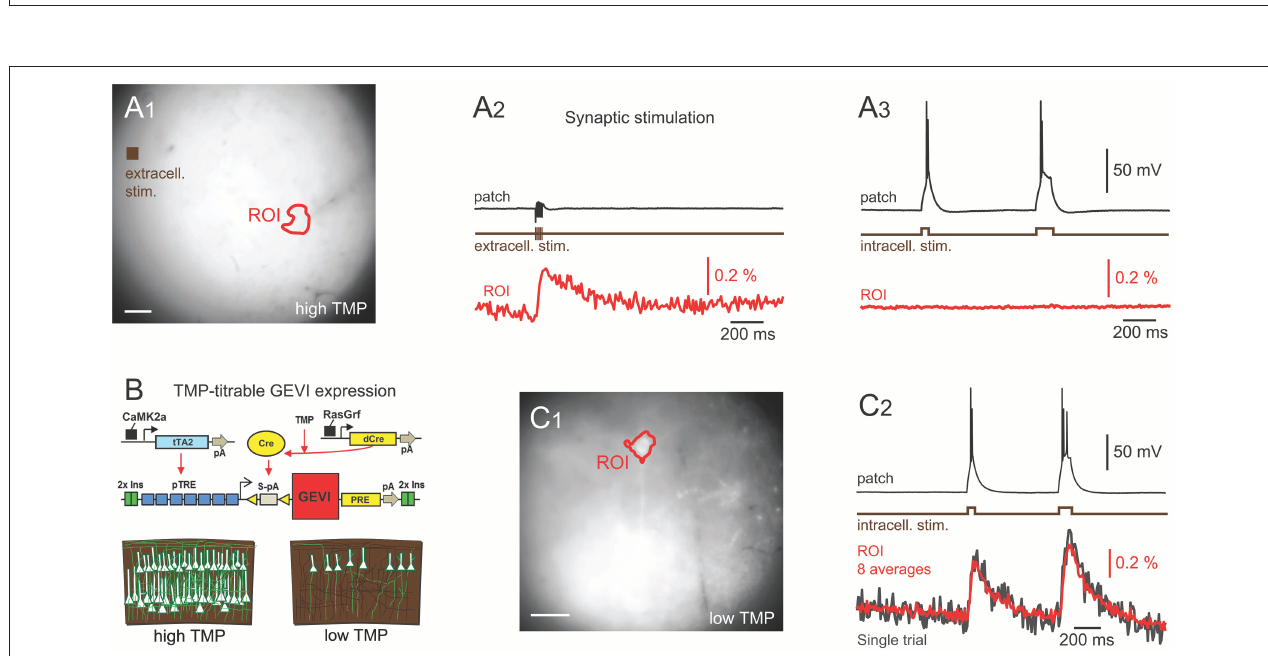
FIGURE 2 | d-Cre modulated sparse expression strategies enable single-cell resolution functional imaging. (A) Population, but not single-cell, voltage signals are resolved with densely expressed GEVIs. (A 1 ) A wide-field image showing the patched cell’s location and the ROI used to generate the voltage imaging trace. An extracellular stimulation electrode was located as indicated. (A 2 ) A train of extracellular stimulation evoked responses from many cells, leading to a clear population voltage response in the cellular ROI. (A 3 ) No single cell voltage signal could be resolved despite averaging of 80 repeated trials of extracellular stimulation. (B) The expression strategy used to generate sparse expression in layer 2/3 pyramidal cells. TMP stabilizes destabilized Cre recombinase enabling TRE driven GEVI expression. (C 1 ) A wide-field image of sparsely expressed GEVI showing the ROI used to calculate the voltage time course. (C 2 ) Single-cell voltage transients can be clearly resolved with sparse expression. Red time course shows an average of eight repeats, gray shows single trial response. Fluorescence traces shown on inverted y